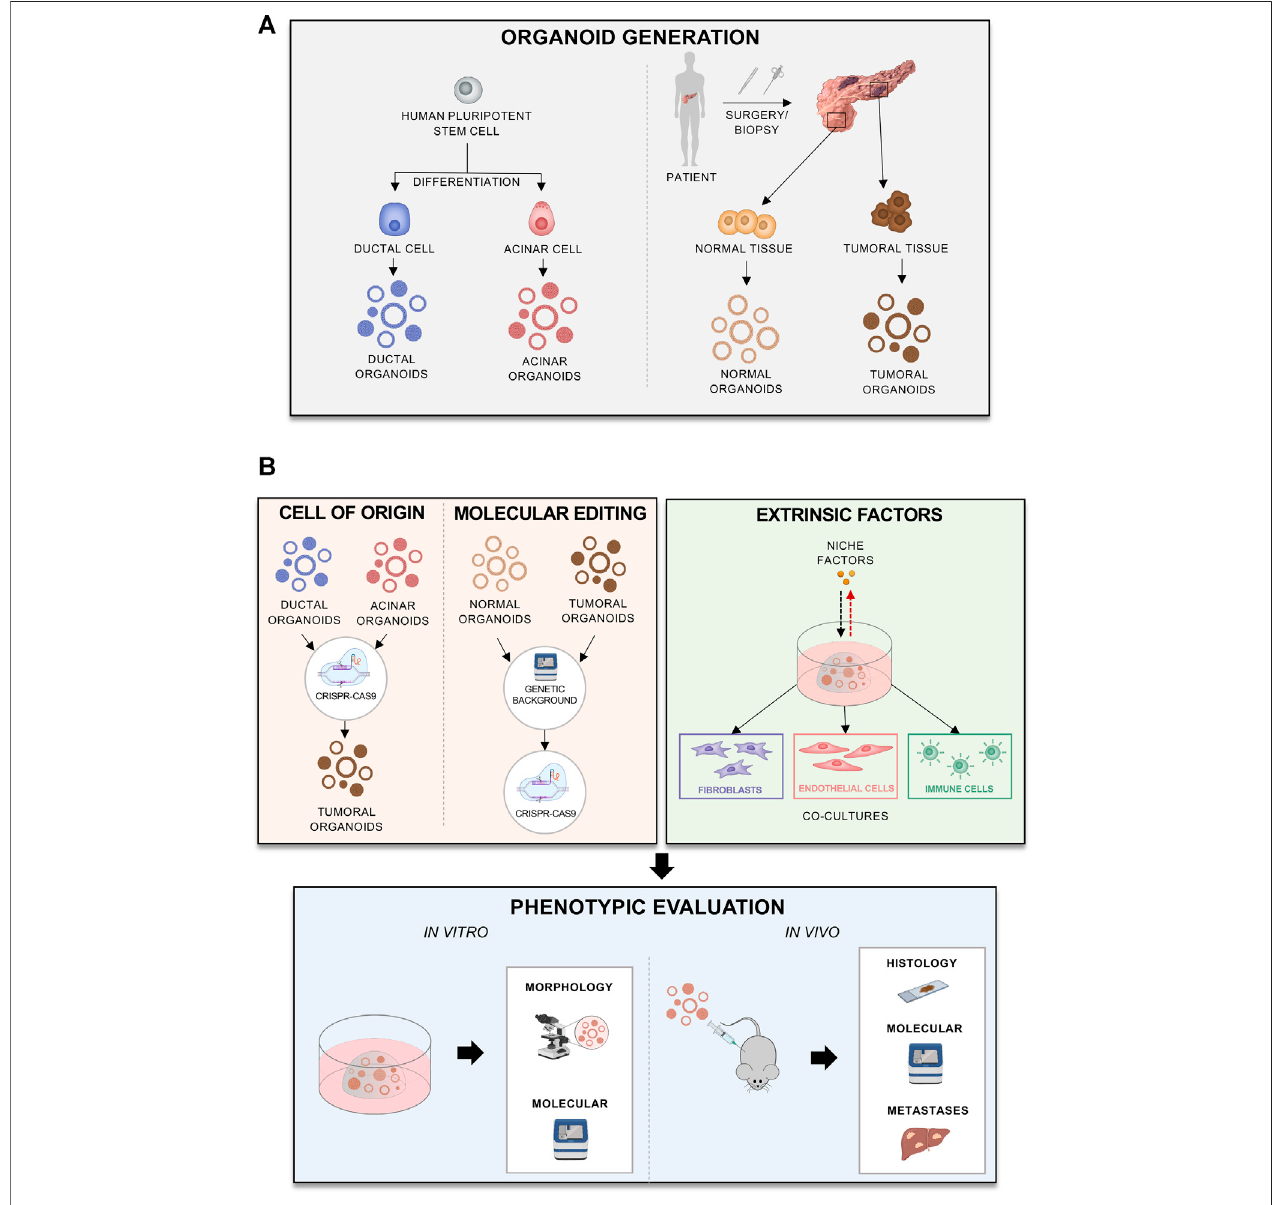
FIGURE3| Differentapplicationsoforganoidstomodelprogression (A) Differentmethodsandsourcesfororganoidderivation. (B) Generationofdifferentorganoid models, re fl ecting cell of origin, mutations of interest, patients ’ background, or effects of extrinsic factors. The models can be phenotypically evaluated in vitro or in vivo .